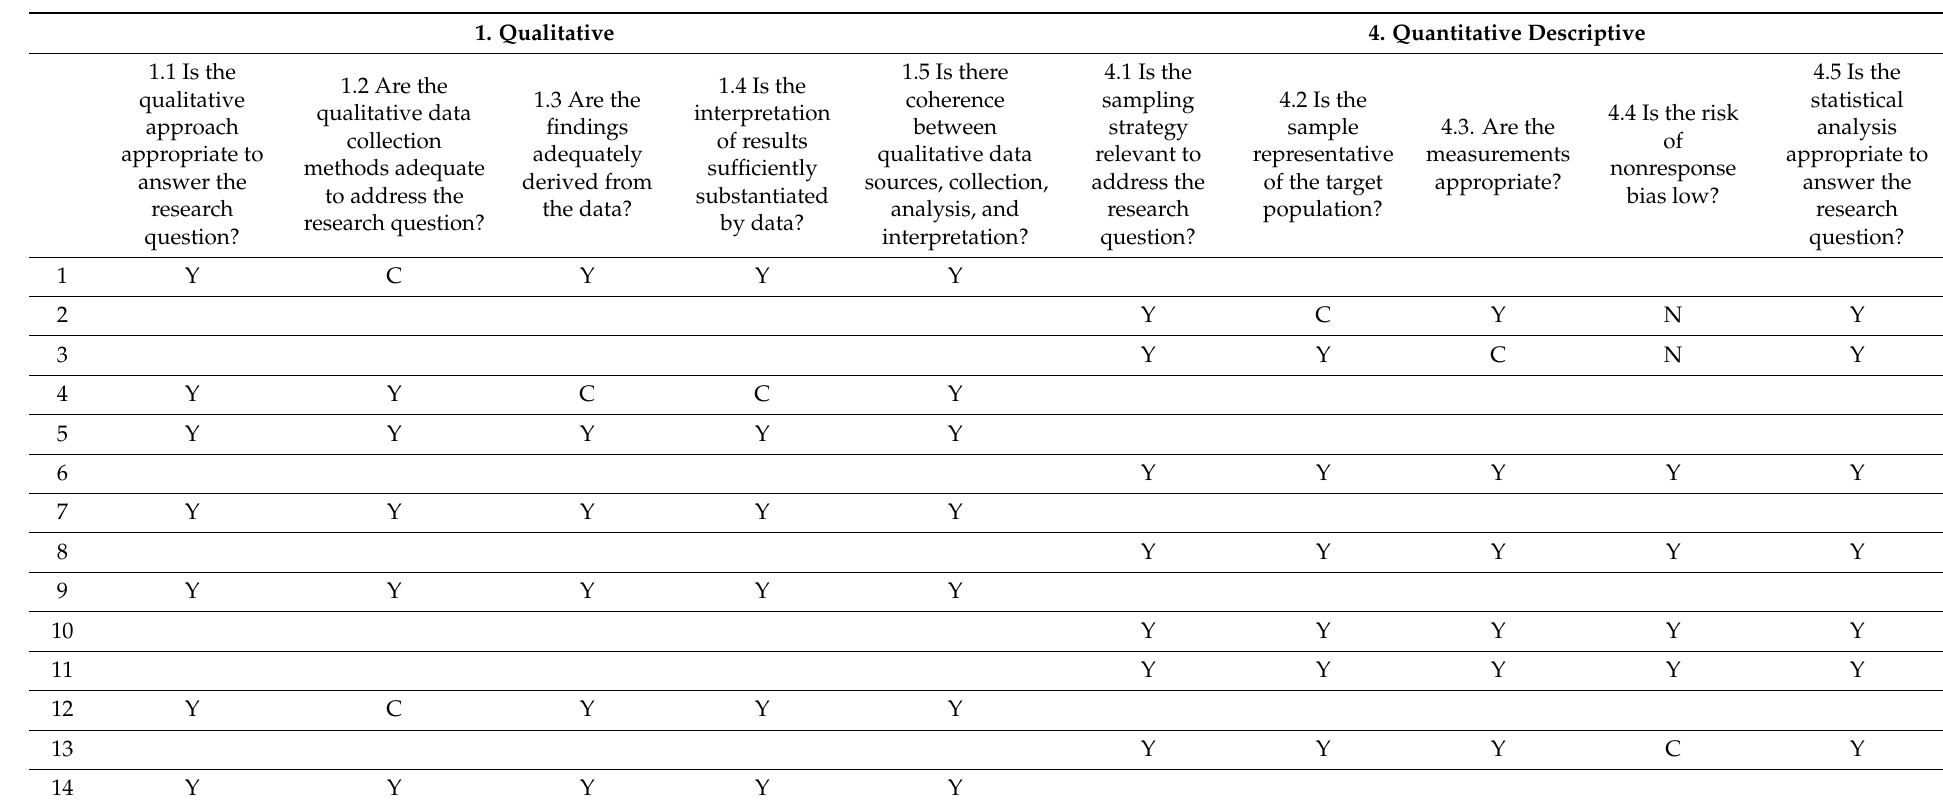
Table 3. MMAT quality appraisal